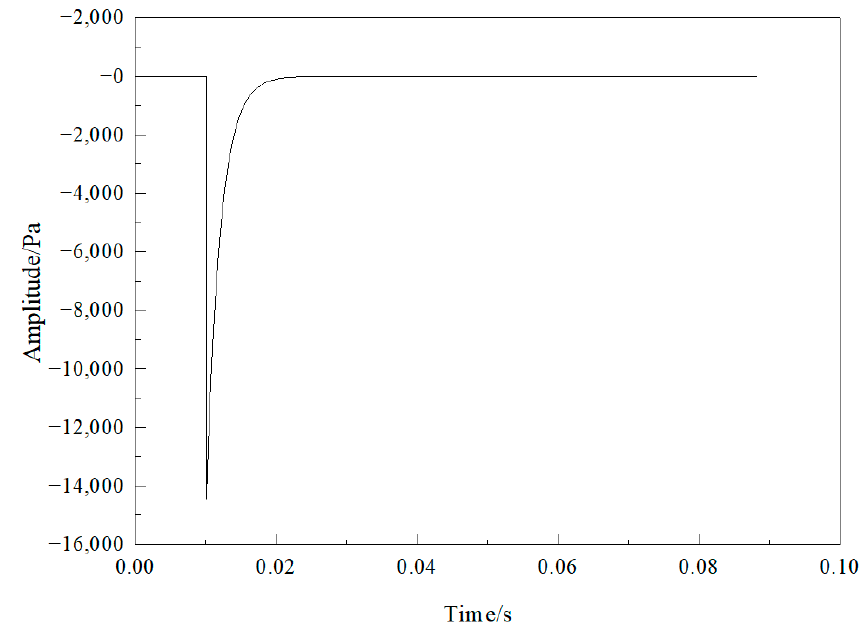
Figure 2. The inlet-pressure boundary condition.